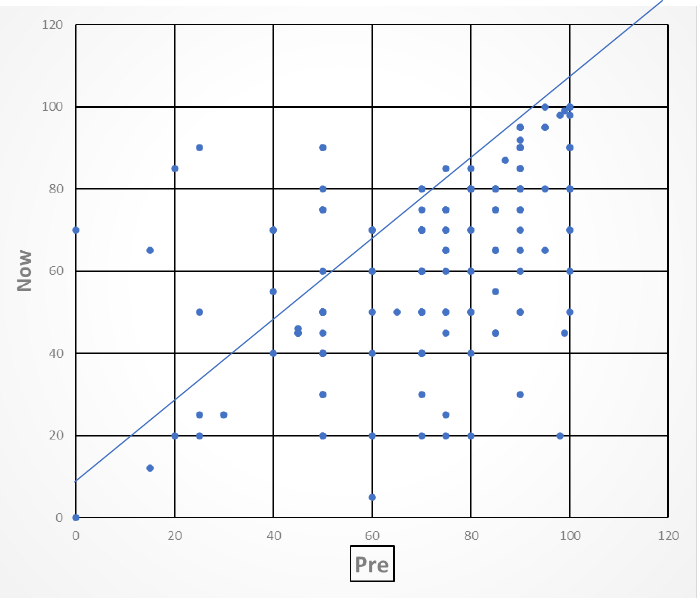
Figure 4. VAS pre-COVID compared with time of interview. Note: The line represents no change in score, and people above the line have better health when triaged compared to before COVID; people below the line are worse.